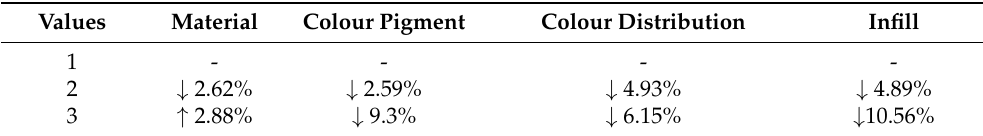
Figure 16. Variation of main effects for surface roughness. Table 7. Degree of variation for Sq roughness.